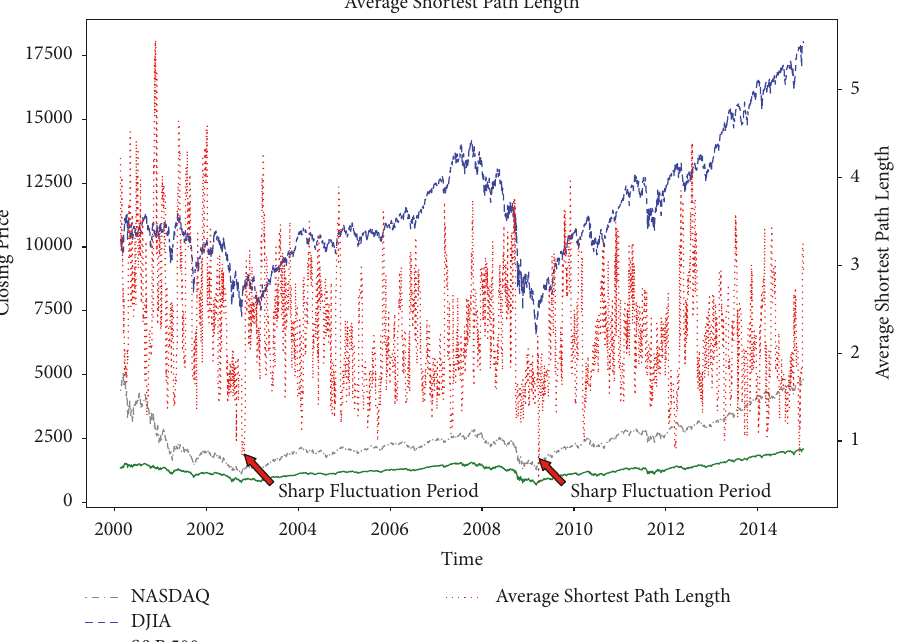
Figure 5: The evolution of the three stock indexes and average shortest path length.